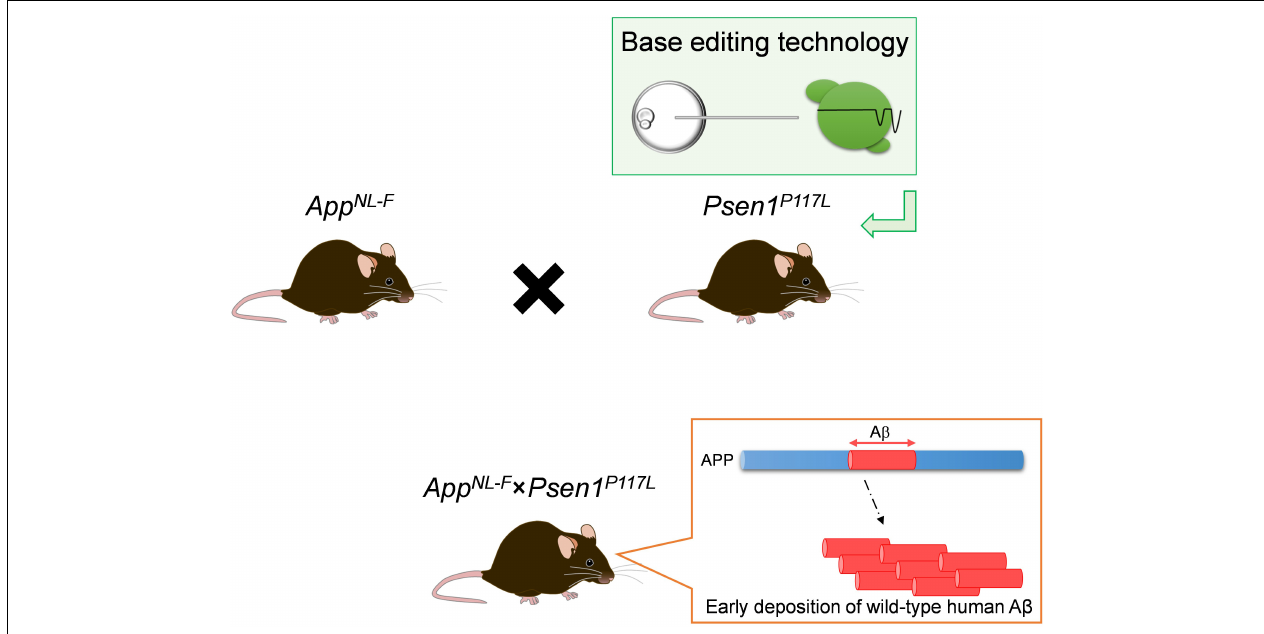
FIGURE 4 | Scheme of App NL − F × Psen1 P 117 L double-mutant mice. For the generation of the double-mutant mice, the App NL − F line was crossbred with the Psen1 P 117 L line whose mutation was introduced in the endogenous Psen1 gene utilizing base editing technology. The synergistic effects of the pathogenic mutations in the App and Psen1 genes strongly accelerates the deposition of wild-type human A β in mouse brains.